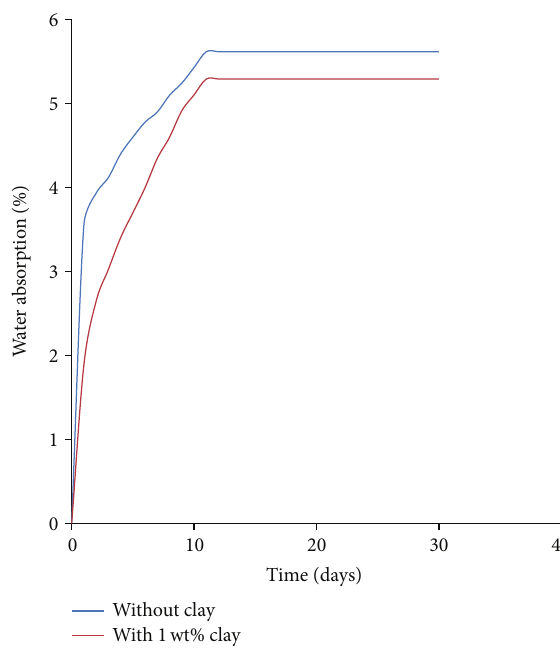
Figure 8: Water absorption of PLA/PCL/OPMF biocomposites and PLA/PCL/1wt% clay/OPMF hybrid